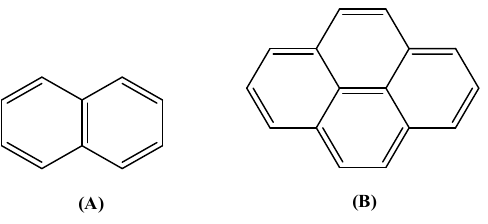
Figure 1. ( A ) The naphthalene ring. ( B ) The pyrene